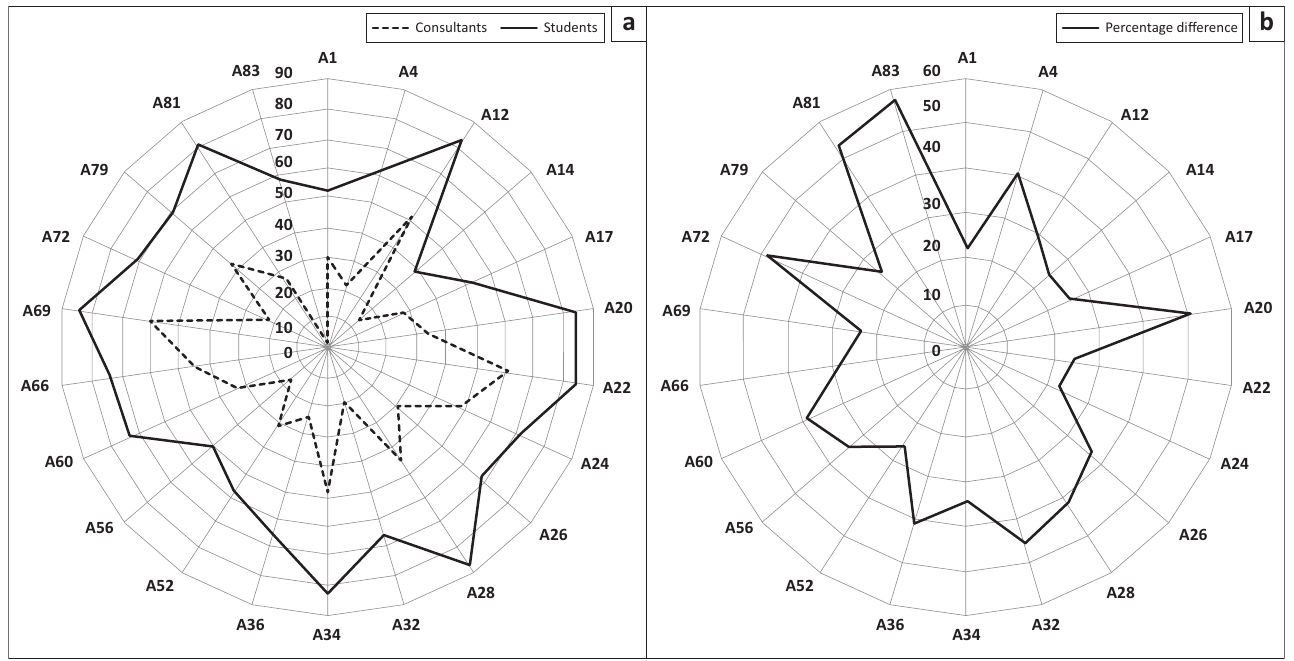
FIGURE 2: A graphical representation (a and b) of the evaluation between writing consultants and students ( Table TABLE 2: Comparing average scores between writing consultants and students. Category